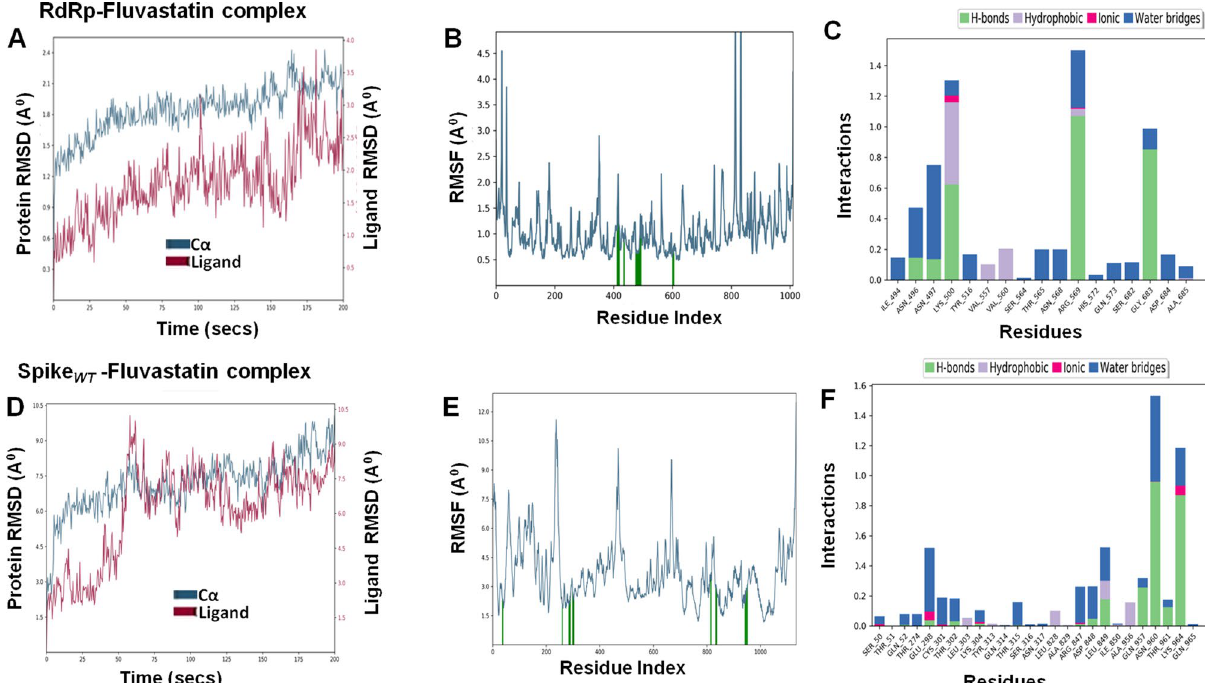
Figure 10. Molecular dynamic simulations of RdRp–fluvastatin complex (A–C) and Spike WT –fluvastatin complex (D–F) , respectively. (A–C) RMSD, RMSF, and protein–ligand interactions of RdRp–fluvastatin complex, respectively. (D–F) RMSD, RMSF, and protein–ligand interactions of Spike WT –fluvastatin complex,